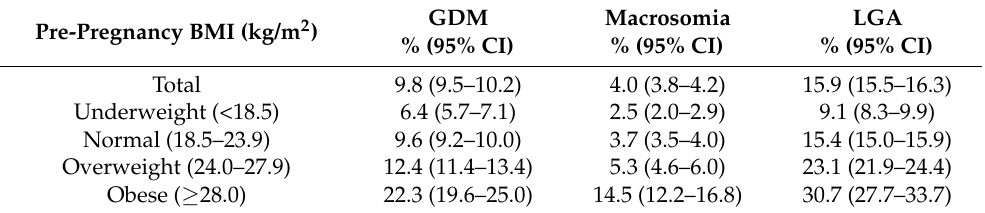
Table 2. Prevalence (% and 95% CI) of GDM, macrosomia, and LGA newborns according to maternal pre-pregnancy